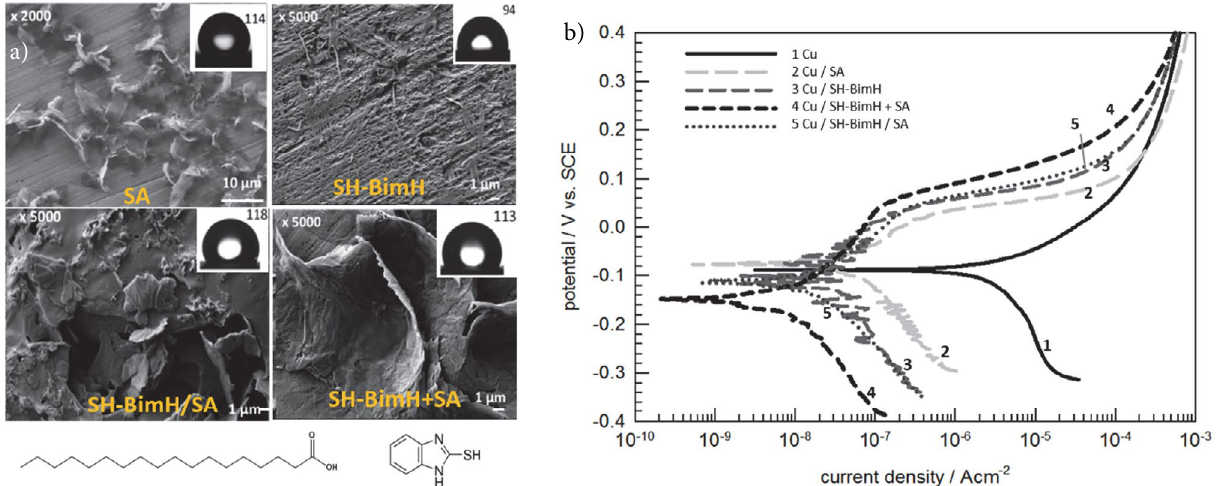
Figure 9. (a) SEM images of copper surface in ethanol solution of different organic compounds: immersed for 20 minutes in 0.05 M octadecanoic (stearic) acid (SA), immersed for 1 h in 0.01 M 2-mercaptobenzimidazole (SH-BimH), 1 h in 0.01 M 2-MBI followed by 20 minutes in 0.05 M SA (SH-BimH/SA), and 1 h in mixture of 0.01 M SH-BimH and 0.05 M SA. (b) Polarization curves recorded for bare copper and modified by inhibitors after 1 h immersion in simulated urban rain. d E /d t =1 mV/s. Skeletal formulae of SA and 2-MBI are presented. ( Reprinted from the publication by